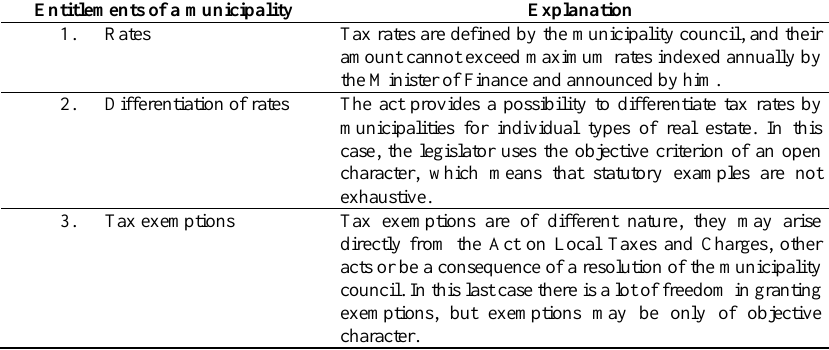
Table 1. Property tax autonomy in Polish local government Entitlements of a municipality